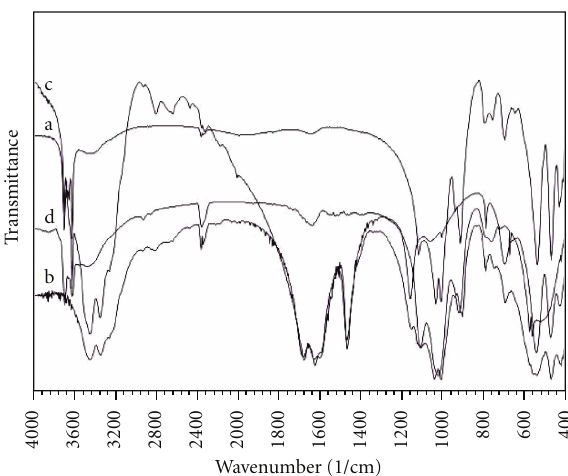
Figure 1: FTIR spectra of (a) neat kaolinite, (b) urea, (c) kaolin/ urea, and (d)